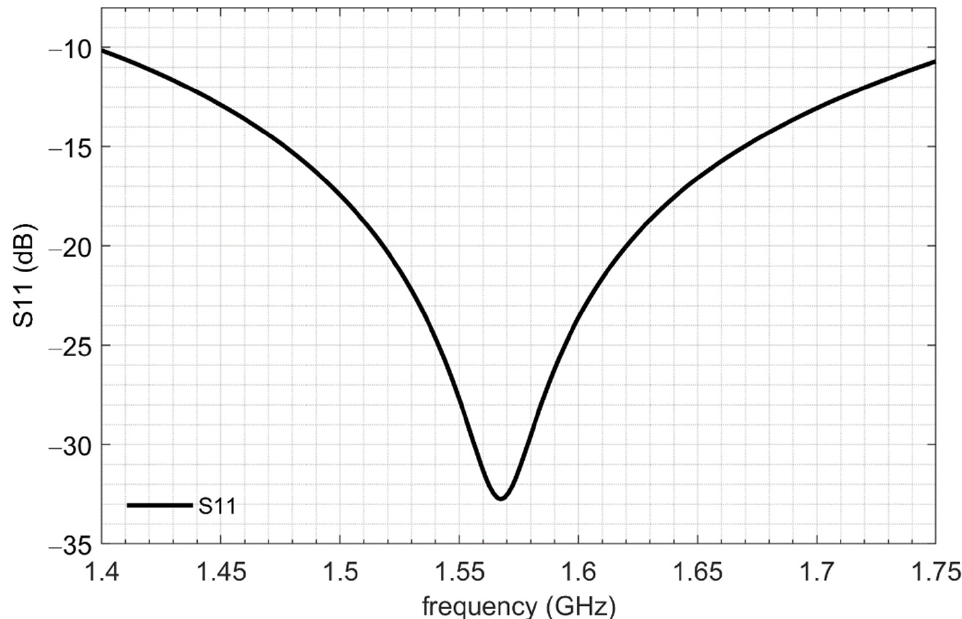
Figure 10. Input impedance matching (S11) of the balun.